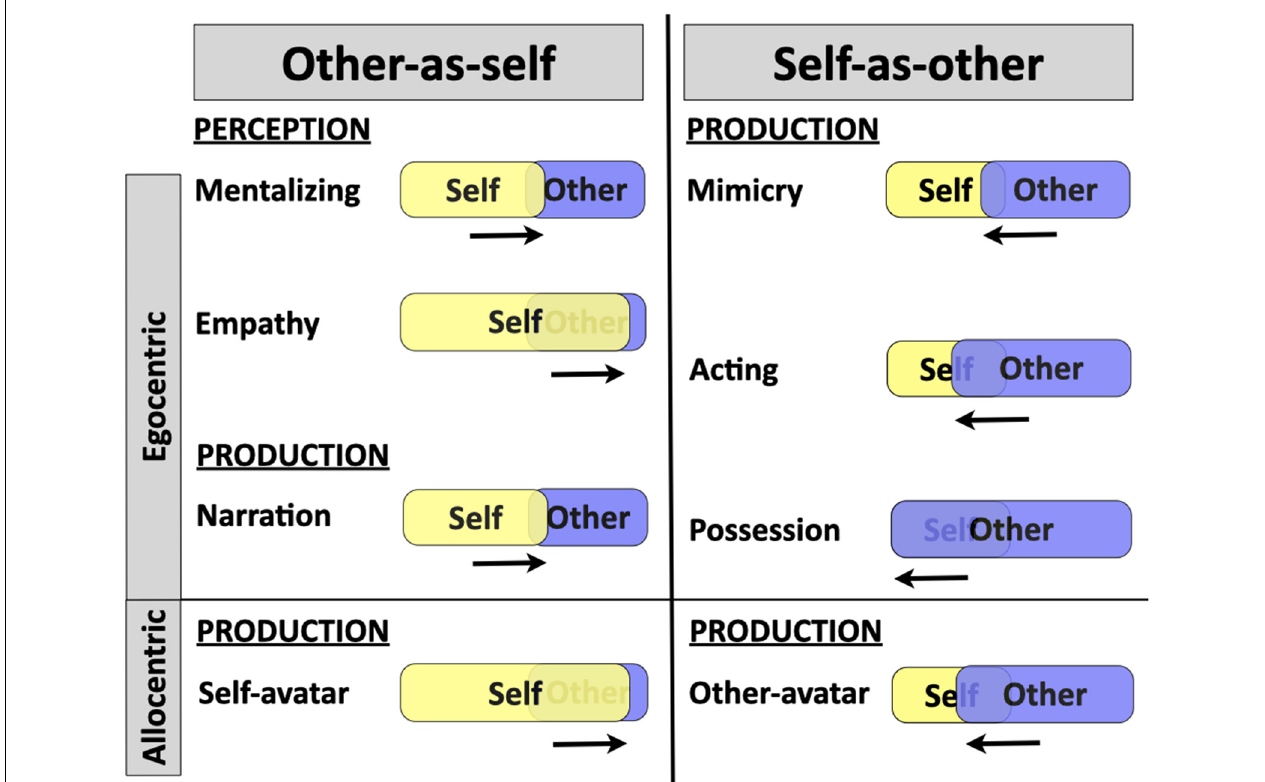
FIGURE 4 | Summary of the narrative mode of social cognition. The principal other-as-self mechanism involves perceiving others egocentrically through mentalizing and empathy. A production counterpart occurs in the form of narration. A second mechanism works in production to represent the self allocentrically using objects such as avatars. The principal self-as-other mechanism involves portraying the other egocentrically through mimicry, acting, and occasionally spirit possession. A second mechanism works to portray others allocentrically using objects, such as puppets and avatars. The figure uses shading and arrows to provide an approximate representation of the dynamics of self and other processing for each mechanism. In mentalizing, empathy, and narration, the self reaches out psychologically to an other’s mind. In the use of self-avatars, the self gets projected onto an object. In mimicry, acting, and possession, an other comes to inhabit the self’s body during a performance. In the use of other-avatars, the portrayal of an “other” occurs using an object, rather than the self’s body. Note that the processes shown horizontally on either side of the central vertical divider are not meant to be paired with one another; the organization is arbitrary.